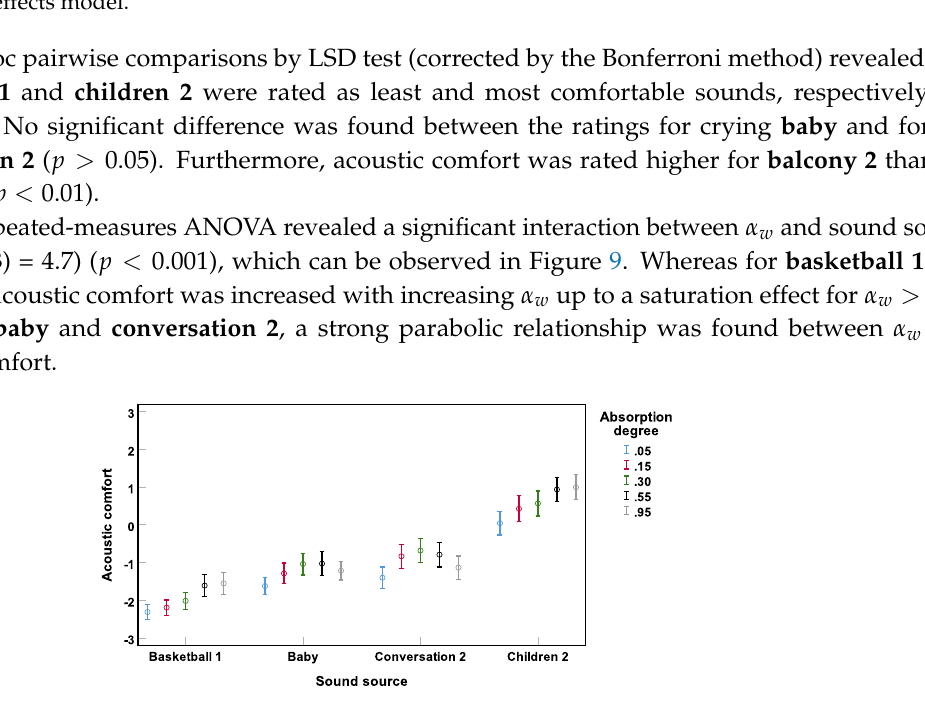
Figure 9. Significant interaction (Experiment 2) between α w and sound source. Mean acoustic comfort ratings across subjects and their 95% confidence intervals are